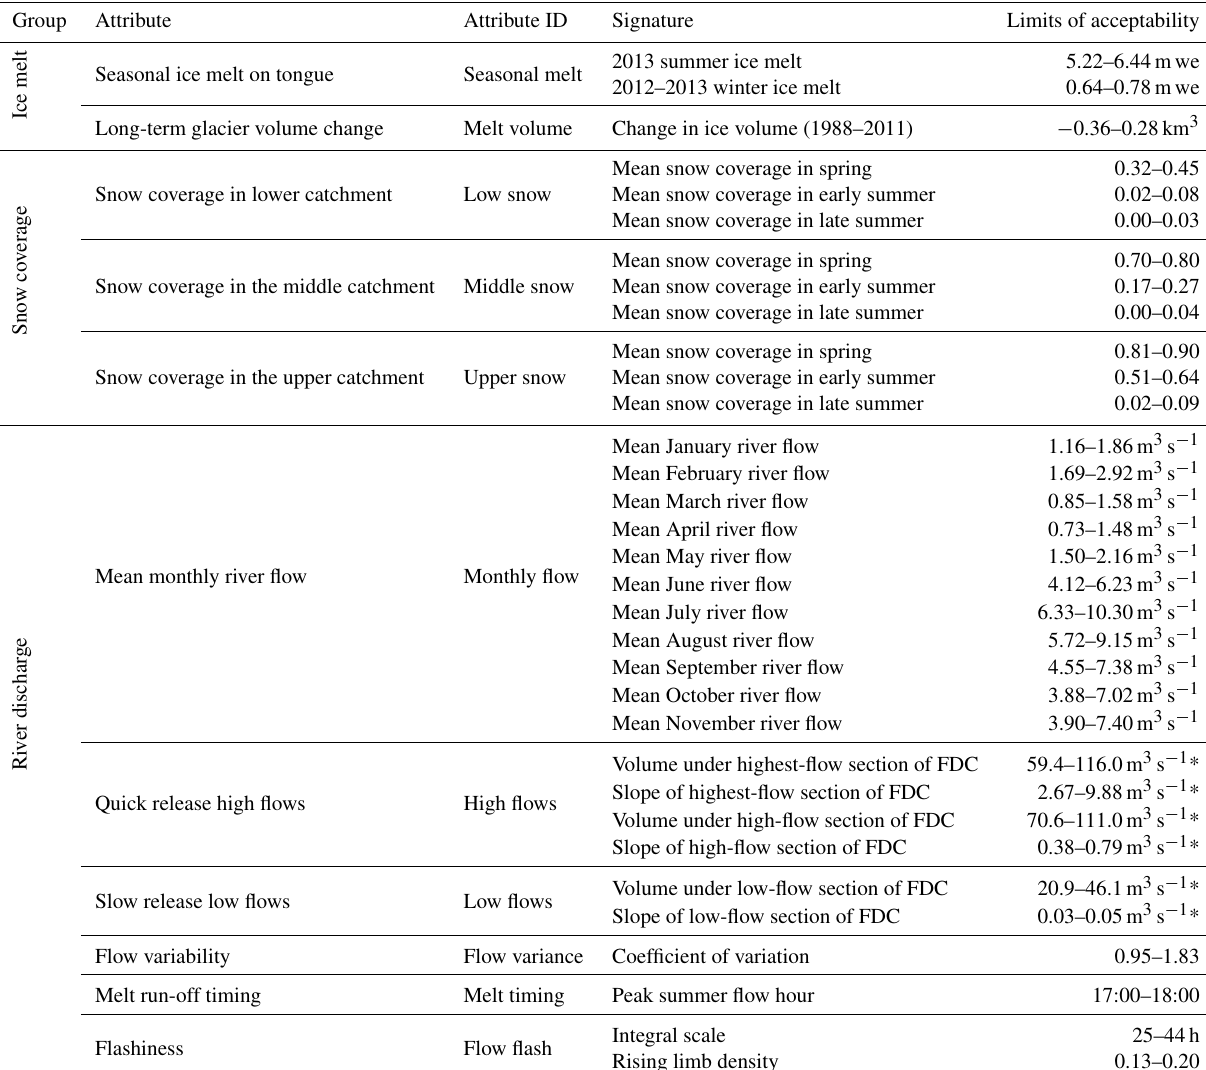
Table 2. Summary of signatures used to evaluate model acceptability. Units with an asterisk (*) are per section of flow duration curve.